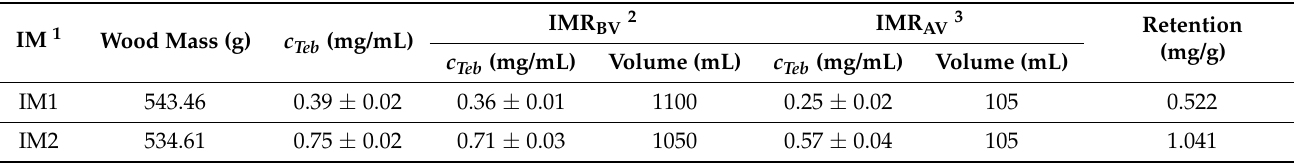
Table 3. Volumes and concentrations of the remaining dispersions after the two stages of the impregnation process, and final retention of tebuconazole upon impregnation. Each value represents the average of two independent replicates with their respective standard